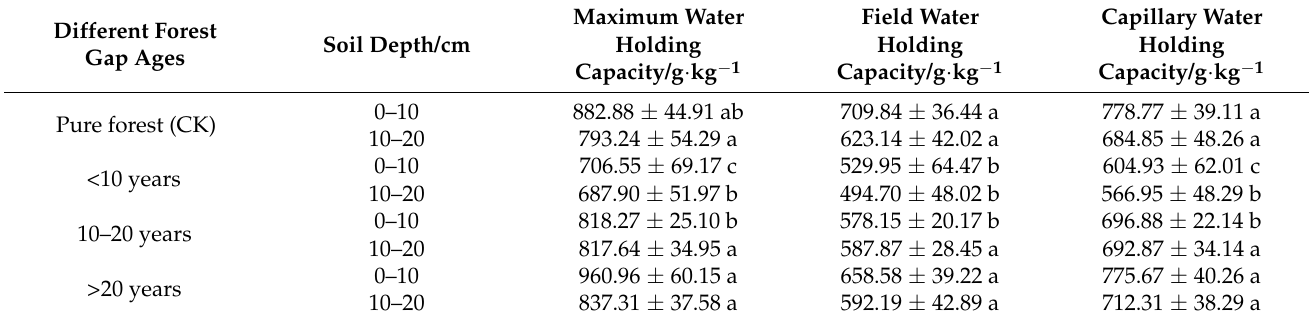
Table 1. Soil water holding capacity characteristics in forest gap of different